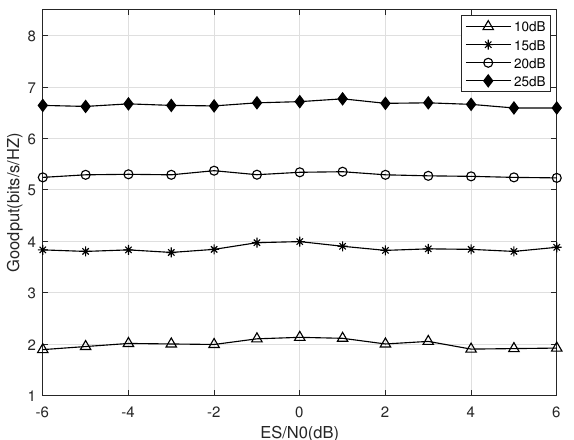
Figure 10. Sensitivity to SNR estimation